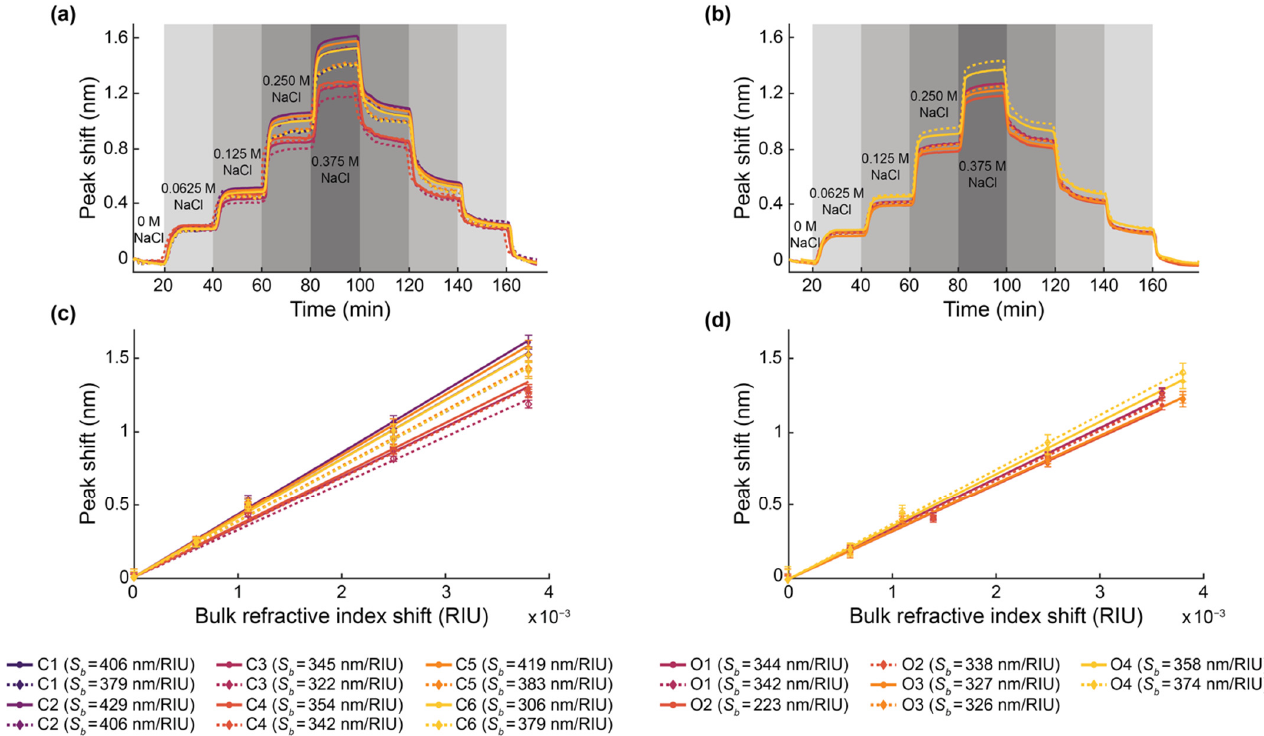
Figure 11. Measured resonance wavelength shifts as a function of NaCl concentration for ( a ) C-band and ( b ) O-band ring resonators. Measurements from the fifth (ascending) and sixth (descending) replicate exposures to five different NaCl concentrations are displayed. Measured resonance wave- length shifts versus bulk refractive index with linear fits for ( c ) C-band and ( d ) O-band ring resonators. The linear fit slopes were used to calculate S b for each resonator. Note that the results presented in ( c , d ) correspond to the fifth replicate of the bulk sensitivity experiments, whereas the S b values reported in Table 5 represent averages measured across all ten replicates. Solid lines correspond to ring resonators located in microfluidic channel 1, whereas dotted lines correspond to ring resonators located in microfluidic channel 2. Additionally, note that the traces for device C1 are hidden under the traces for device C6 in ( a , c ).